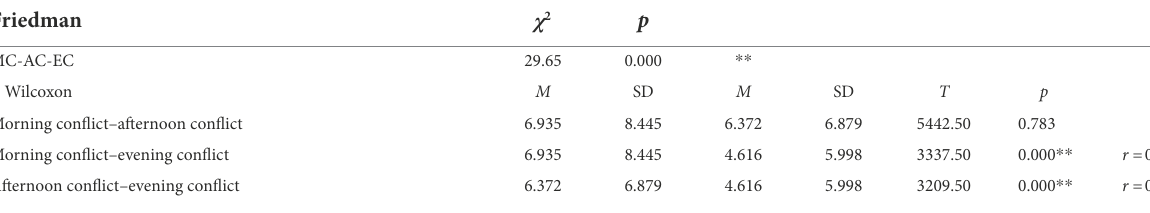
TABLE 4 Results of Friedman’s test and multiple a posteriori contrasts of conflicts at home. Comparison mornings: